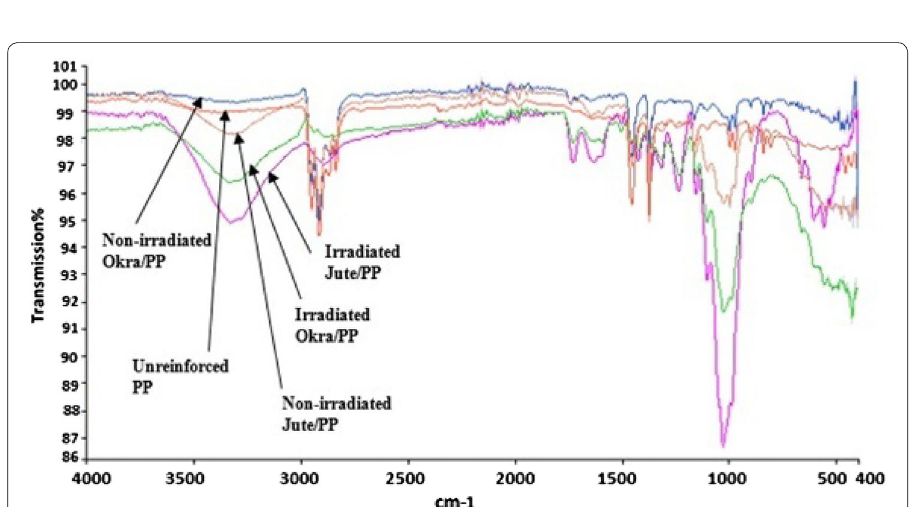
Fig. 8 FTIR-ATR spectra of unreinforced PP and